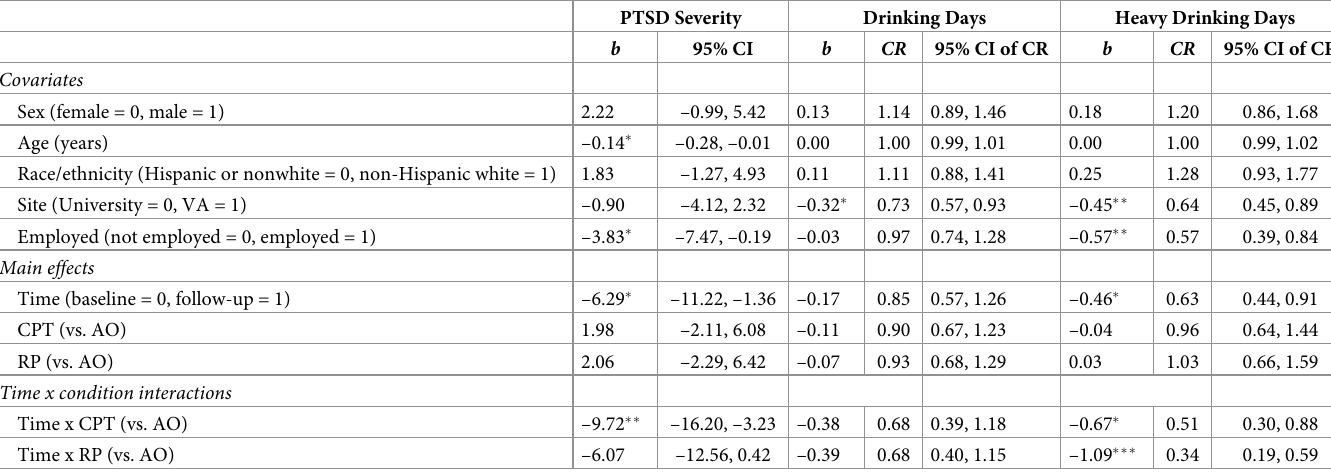
Table 2. Model estimates for initial